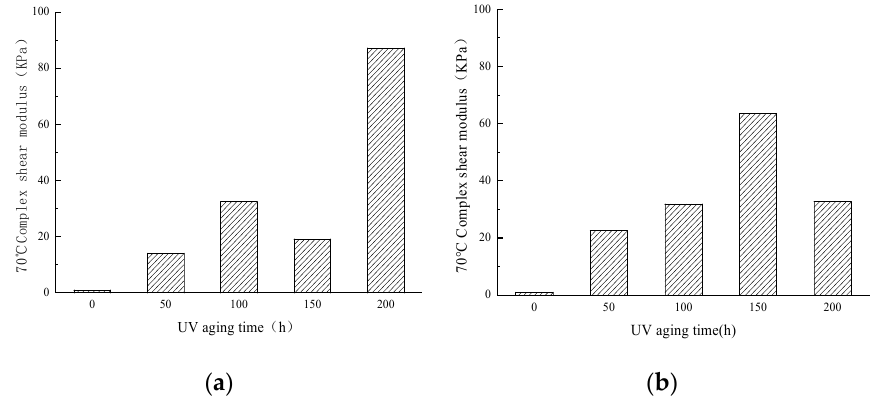
Figure 5. Complex shear modulus (70 °C) of WMA. ( a ) Oxygen isolation conditions. ( b ) Oxygen ‐ containing conditions.